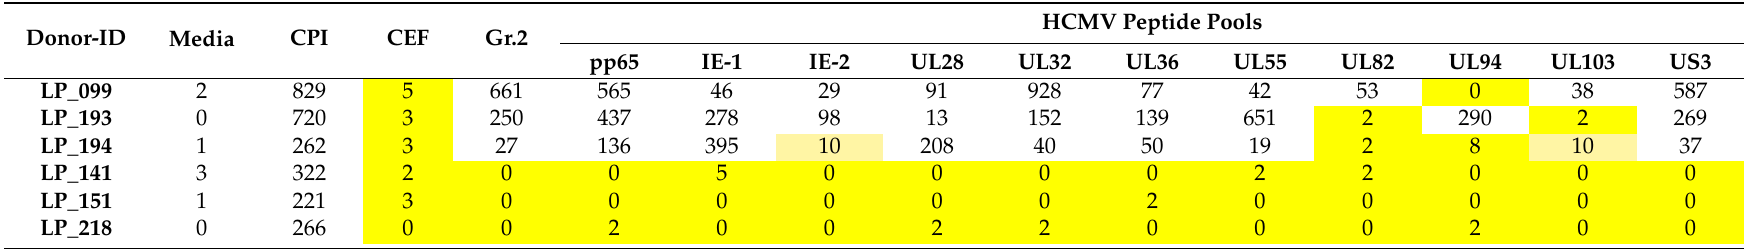
Table 2. Recall response to the CEF pool in comparison to the Human Cytomegalovirus (HCMV Gr.2 antigen and 11 different HCMV peptide pools. Six PBMC donors were selected that were CEF recall negative but either responded to HCMV Gr antigen ( n = 3) or did not respond to HCMV Gr 2 antigen. All donors were tested additionally for reactivity to 11 peptide pools that each cover different HCMV antigens. Mean SFU counts for three replicate wells are shown. Negative recall response to the specified antigens are highlighted in yellow, borderline responses in light